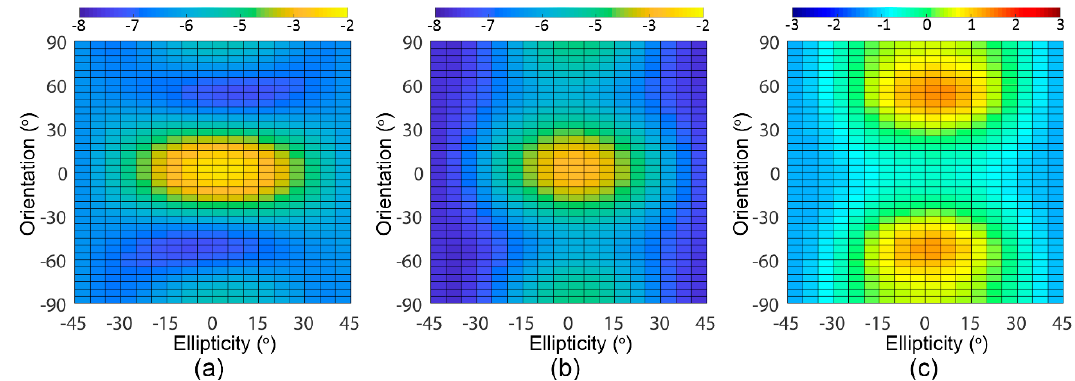
Figure 3. Co-polarization response plots for building-damaged areas at ( a ) pre- and ( b ) post-earthquake conditions, and ( c ) difference between polarization responses.